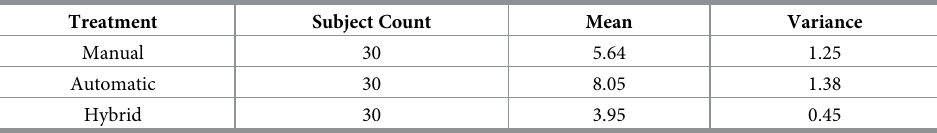
Table 11. Data summary—Viewpoint #2.